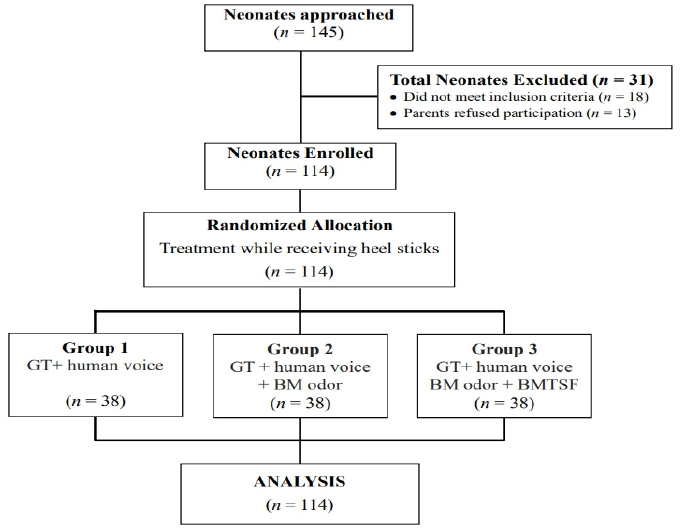
Figure 1. Flowchart of participant recruitment for the three treatment interventions. GT, gentle touch + human voice = control condition; BM, breast milk; BMTSF, breast milk taste by syringe feed- ing.